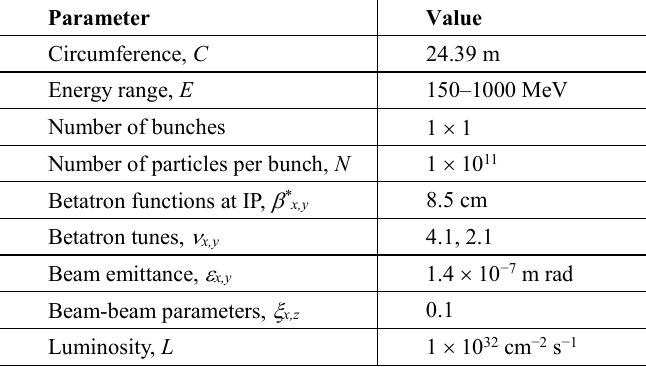
Table 3. VEPP-2000 design parameters (at E = 1